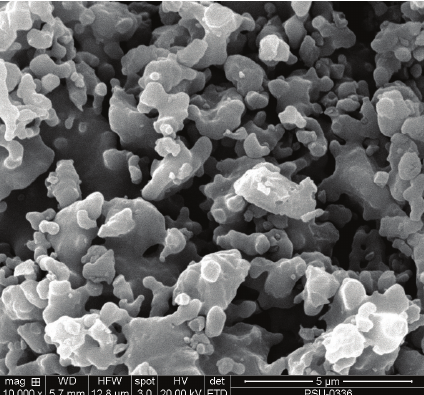
Figure 2: SEM micrograph of RHA